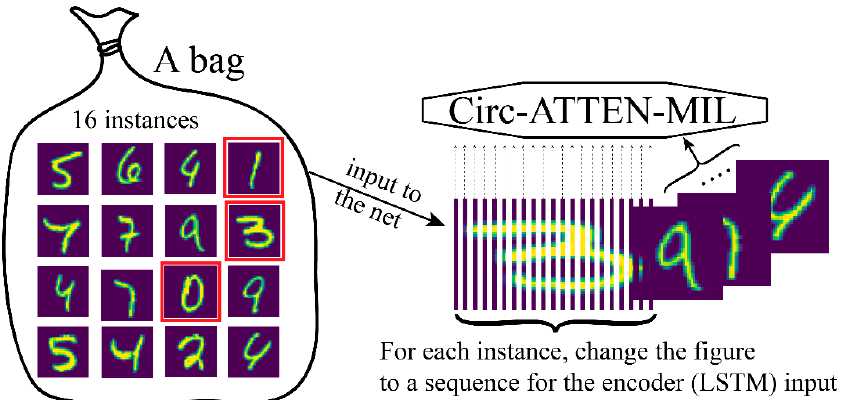
Figure 3. Handling of handwritten numbers dataset for feeding into Circ ‐ ATTEN ‐ MIL.